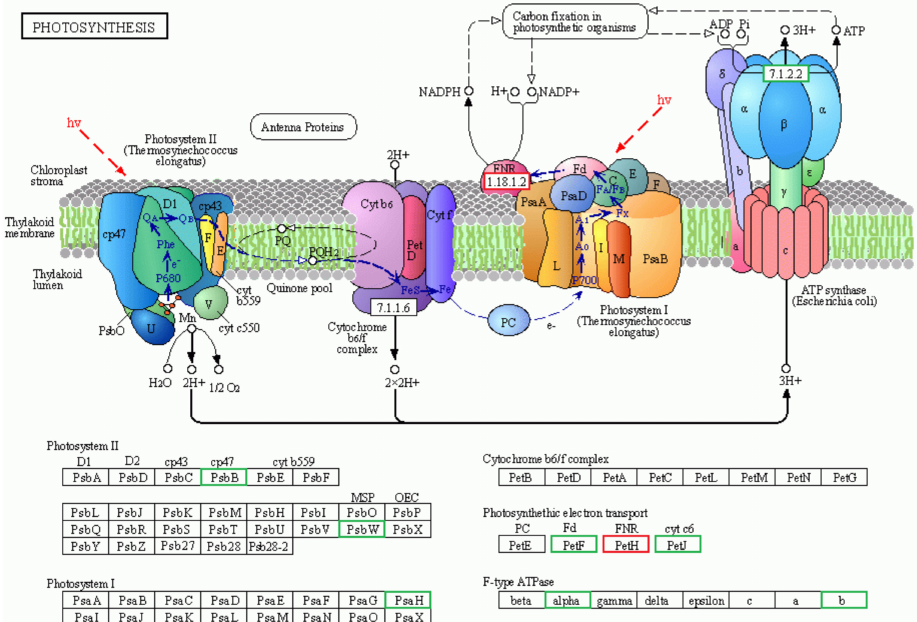
Figure 3. Schematic diagram of DEGs in the photosynthesis pathway of haploid ginkgo. Green indicated down-regulated expression and red indicated up-regulated